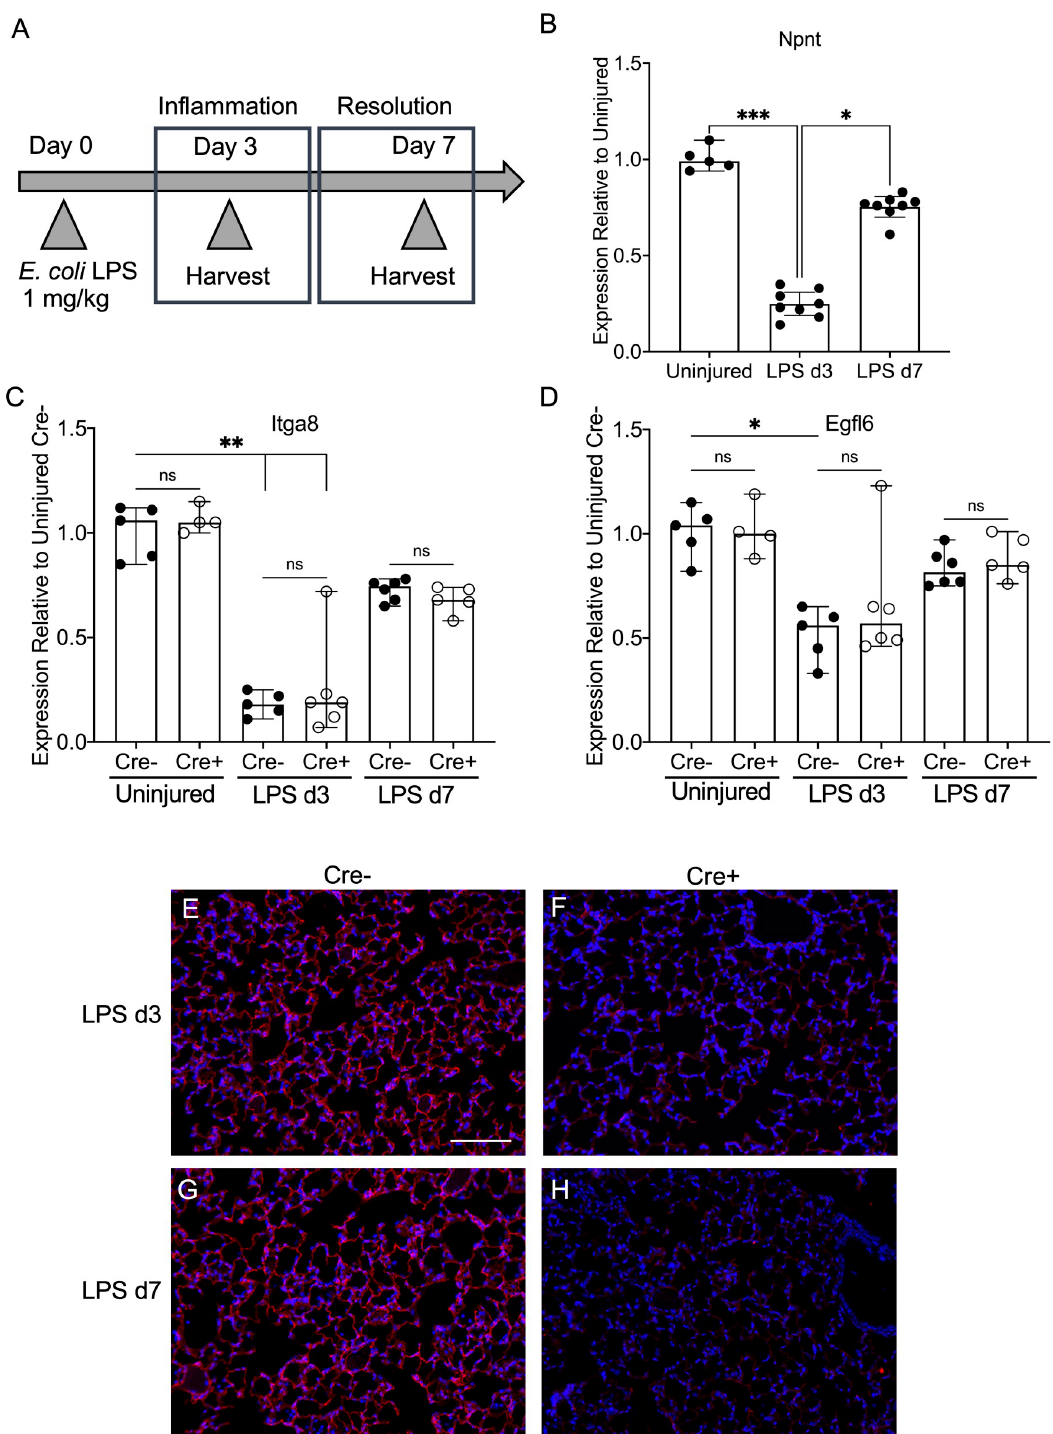
Fig 2. Effect of LPS lung injury on expression of Npnt and related genes. (A) Schematic of the time course of LPS injury and sample acquisition. (B) mRNA levels of Npnt in lungs from Cre- mice were measured by qPCR and expression calculated relative to uninjured. qPCR was also used to determine if expression of integrin α 8 ( Itga8 ) (C) or the NPNT homologue EGFL6 (D) is altered by LPS injury of Cre+ lungs. Gene expression was calculated relative to uninjured Cre-. Shown are the medians (bars) with 95% confidence intervals. Data were analyzed using either the Mann-Whitney or Kruskal-Wallis statistical test. � , p < 0.05; �� , p < 0.01; ��� , p < 0.001; ns, not significant. (E-H) Immunofluorescence for NPNT at day 3 (E and F) and day 7 (G and H) post LPS in Cre- (E and G) and Cre+ (F and H) lung tissue. Nuclei were stained with DAPI (blue). Scale bar = 100 μ m.